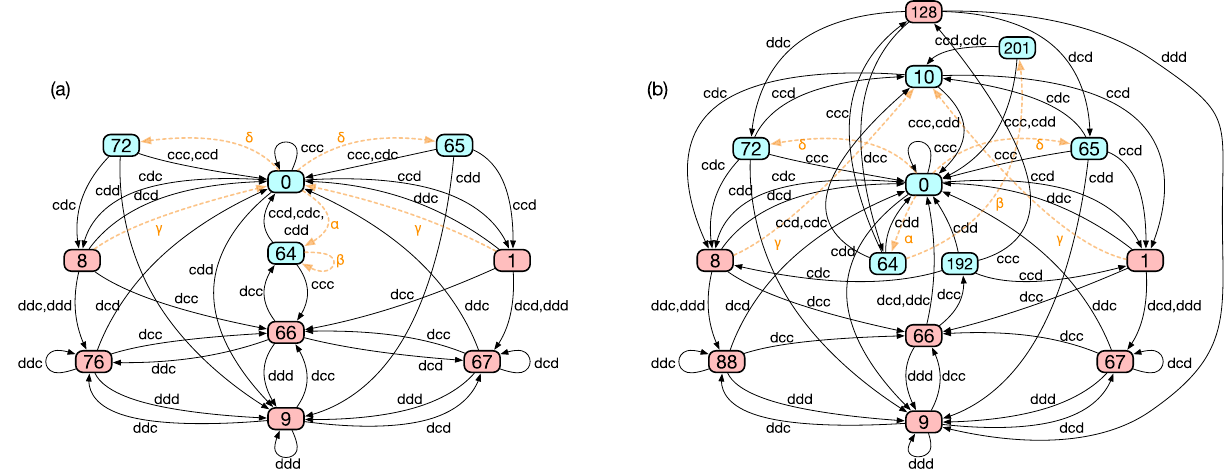
Figure 6. DFA minimization results of fully successful strategies for n = 3 public-goods game. One of the simplest and one of the most complex strategies are depicted in ( a , b ) respectively. The labels and the colours are given in the same way as in Fig. 4b. The dashed orange arrows indicate erroneous actions occurring while recovering mutual cooperation from one- and two-bit errors. The Greek letters correspond to the transitions shown in Fig. tolerance is a necessary condition for full efficiency in this three-person game 27 . When Alice, Bob, and Charlie have adopted this FUSS in common, we can show that the players recover cooperation from every possible type of one- and two-bit error by enumerating all the possible cases: